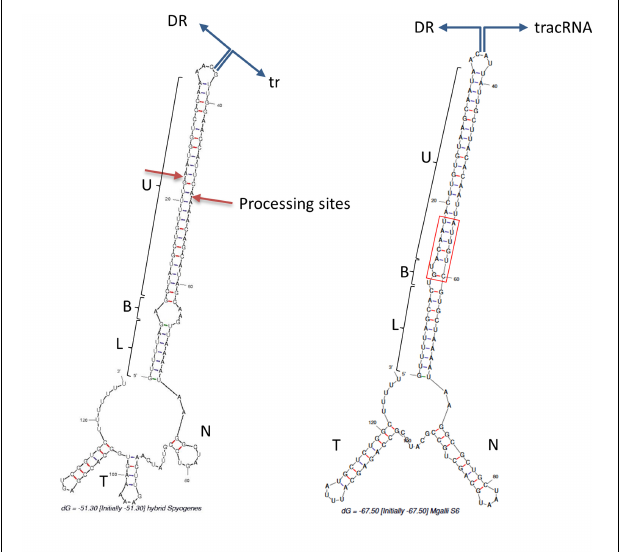
FIGURE 4 | Predicted DR/tracrRNA hybrid secondary structure. Sequences of DR and tracrRNA were concatenated and the secondary structures of the hybrids were simulated using the mfold software at http://unafold.rna.albany. edu/. Position of the DR/tracrRNA concatenation is indicated by divergent blue arrows. Predicted stems involving DR and tracrRNA anti-repeats include a lower stem (L), a bulge (B), and an upper stem (U). For S. pyogenes , processing sites of the natural hybrid by RNAse III are indicated by red arrows. For M. gallisepticum S6, DR and tracrRNA sequences were defined based on (Chylinski et al., 2014) and our own work. N, nexus stem-loop; T, terminator. The base of the upper stem loop that is highly conserved in mycoplasmas is framed in red.